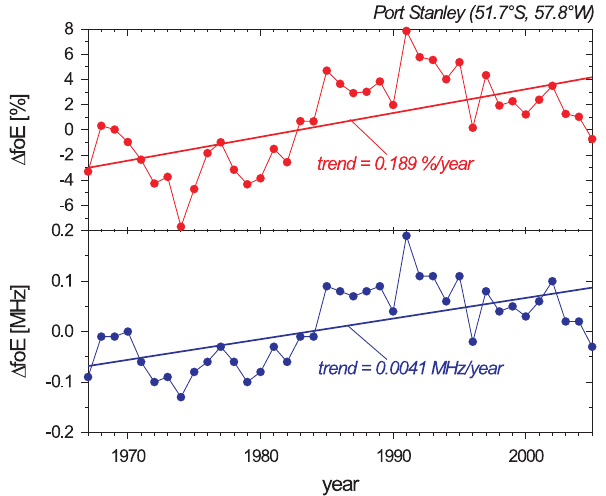
Fig. 4. Trends in foE of the ionosonde station Port Stanley derived from absolute (lower part) and relative differences (upper part) be- tween experimental and regression model